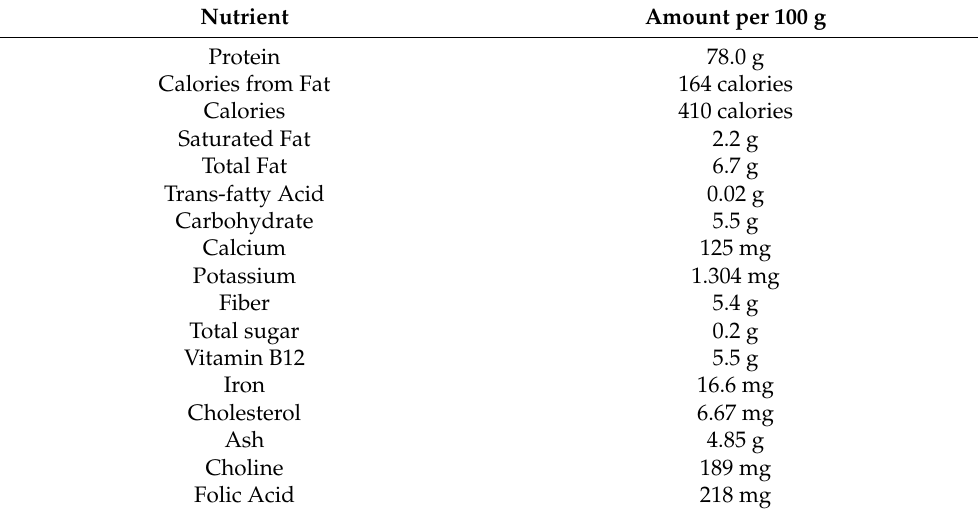
Figure A1. Cricket ( Acheta domesticus ) powder used in the study. Table A1. Nutritional data of the cricket powder. This information is based on 100 g of powder based on the item description/nutrition facts from the JR Unique Foods website [100].